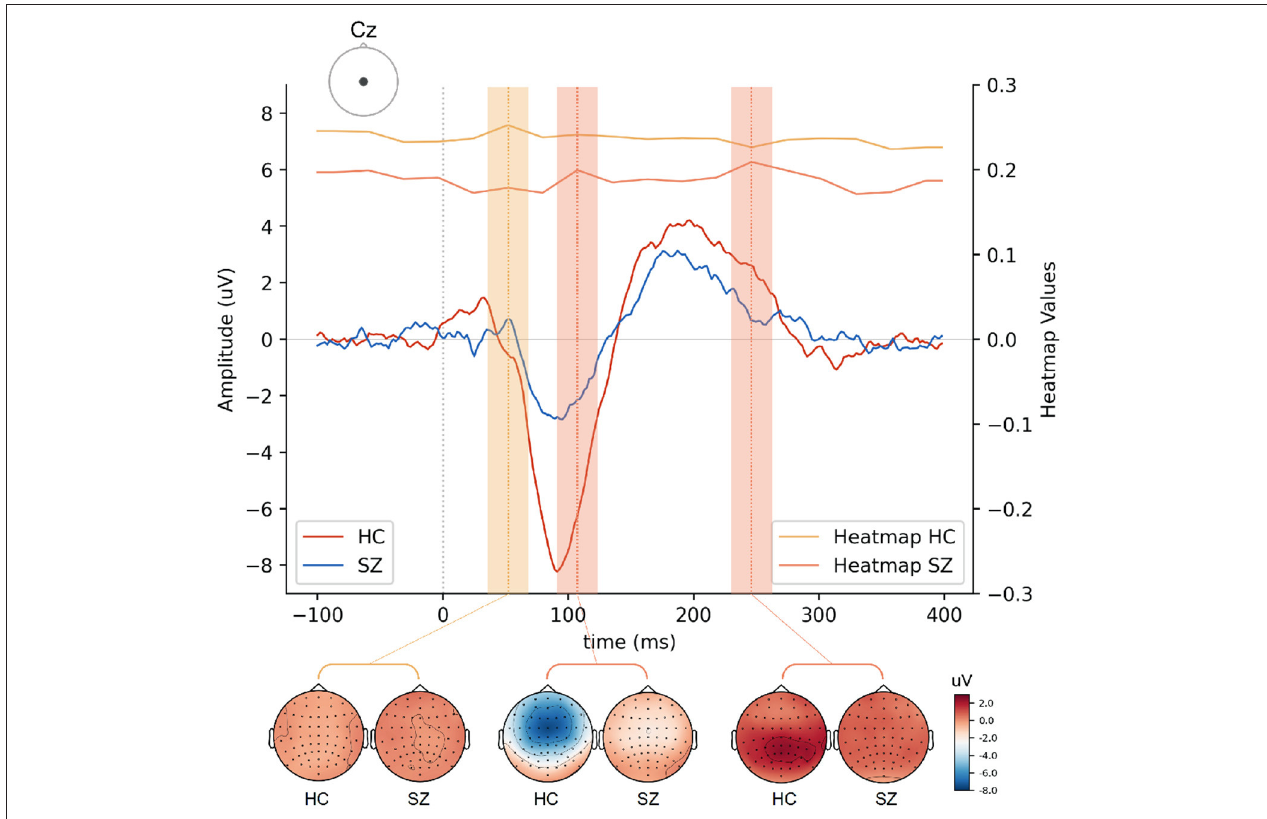
FIGURE 9 | Grad-CAM heatmaps cross-section and averaged EEG signals over Cz electrode drawn for HC and SZ groups. The time intervals associated with the most relevant features are shaded with the color corresponding to the heatmap of each group. Topographical distribution maps of EEG signal amplitudes at those time intervals are also presented for each